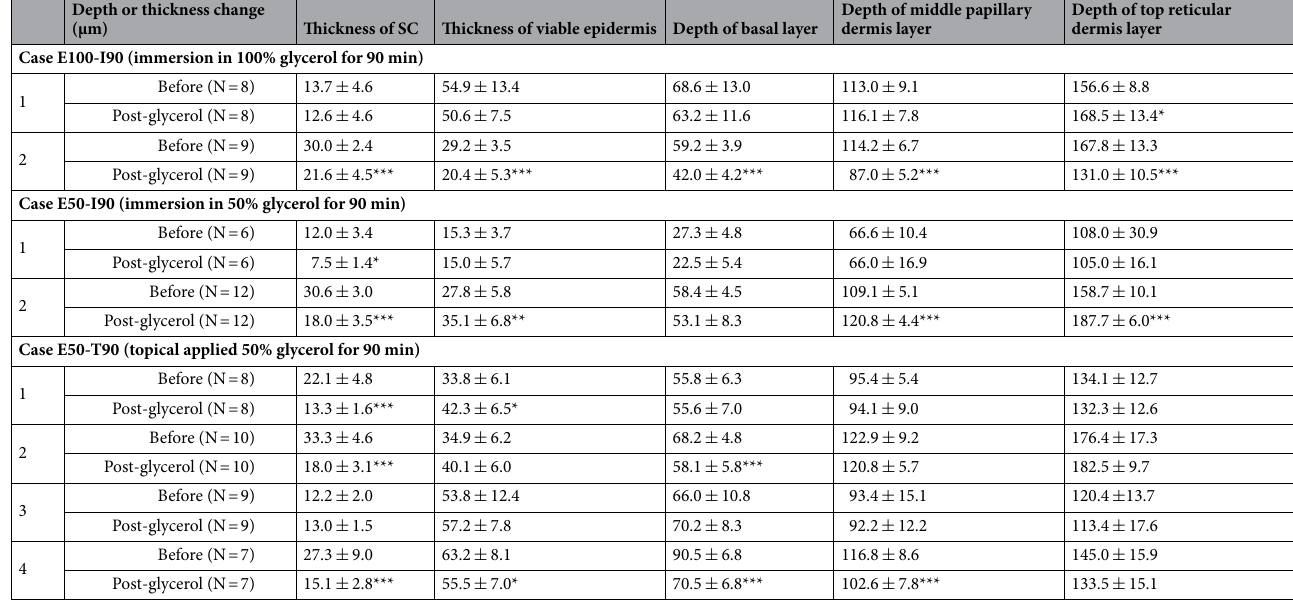
Table 1. Skin structure analysis results of all studied cases. (* P < 0.05, ** P < 0.01, *** P < 0.001).